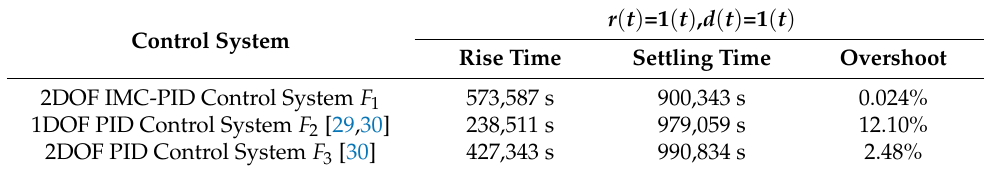
Table 3. Performance of three control systems when the disturbance signal is d ( t ) = 1 ( t ) .